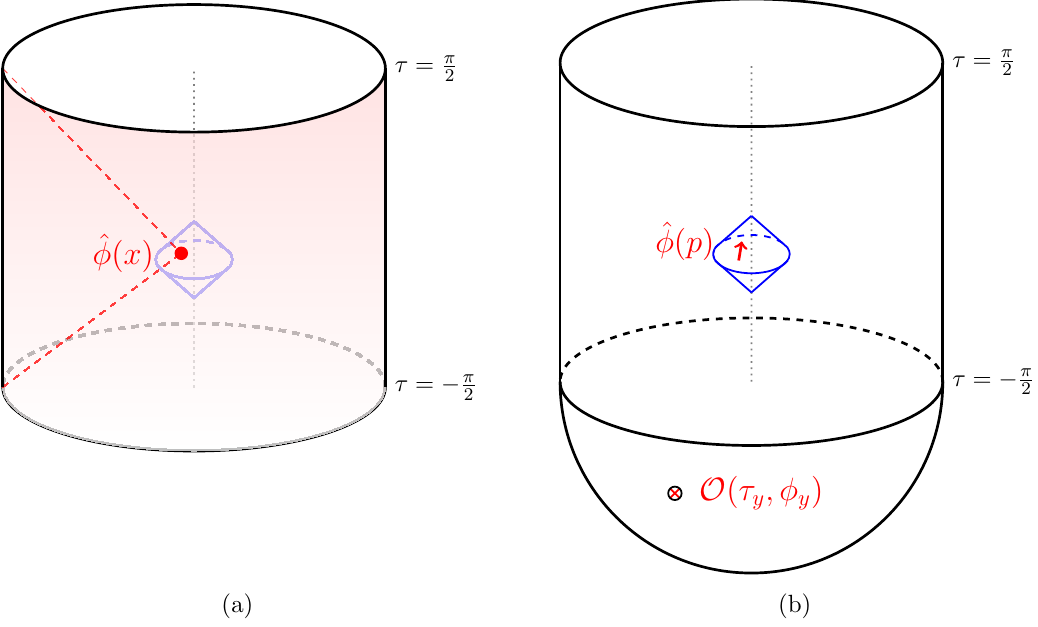
Figure 1. Construction of flat space scattering states from states in a conformal field theory. (a) The bulk field ˆ φ ( x ) is placed inside a scattering region around the center of global AdS (blue). The local operator can be reconstructed semi-classically in the boundary using the HKLL formula (2.3). The reconstruction involves the shaded red part of the boundary, which is space-like separated to the scattering region. (b) After performing a Fourier transform with respect to the flat space coordinates and implementing a flat limit, the reconstruction is performed by placing a primary operator in a Euclidean continuation of the boundary manifold. If the flat space particle is massless, the CFT operator is inserted at a real value of global time τ = π/ ±